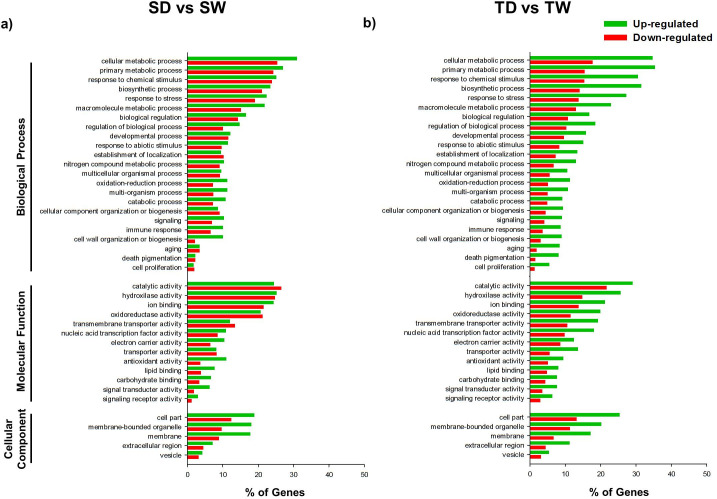
Gene Ontology functional annotation of DEGs in SD vs SW and TD vs TW treatments.GO Slim terms for Biological Process, Molecular Function, and Cellular Component assigned to up-regulated and down-regulated genes (%) found in (a) the susceptible C. papaya genotype under WDS for 14 d.p.t. compared to well-watered (SD vs SW). and (b) the wild tolerant C. papaya genotype under WDS for 14 d.p.t. compared to well-watered treatment (TD vs TW). GO associations were assigned by a BLASTX search against A. thaliana proteome.